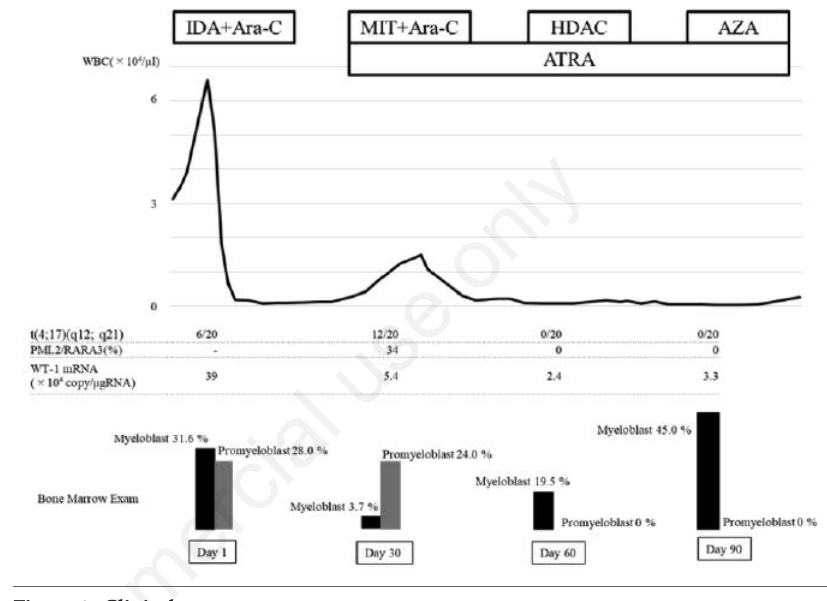
Figure 1. Clinical course.